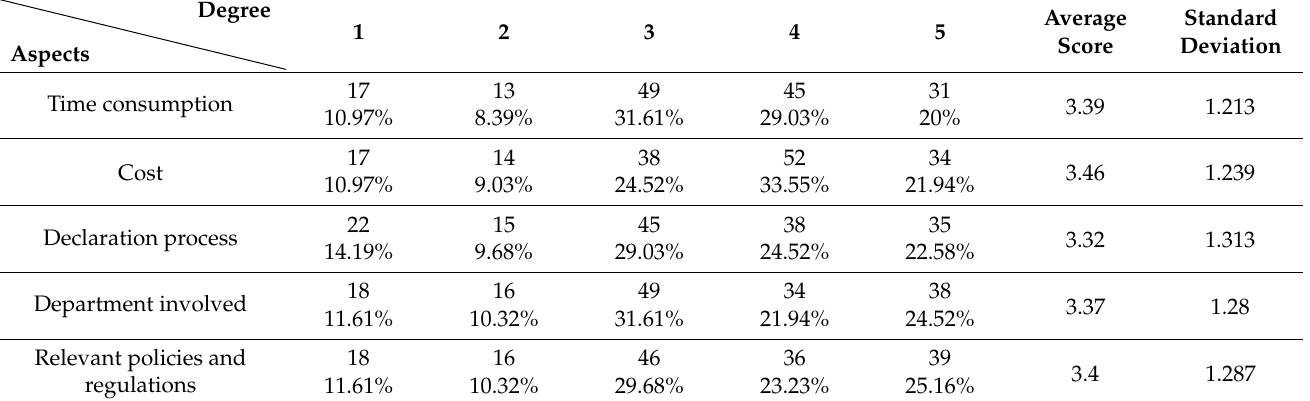
Table 12. The knowledge about the protection and renovation process of public/private